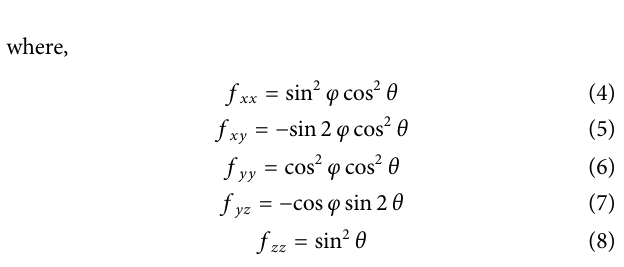
FIGURE 2 | Curves of the lattice strain varying with the azimuthal angle. The experimental curve (black line) and the curve calculated by the plane stress function (red